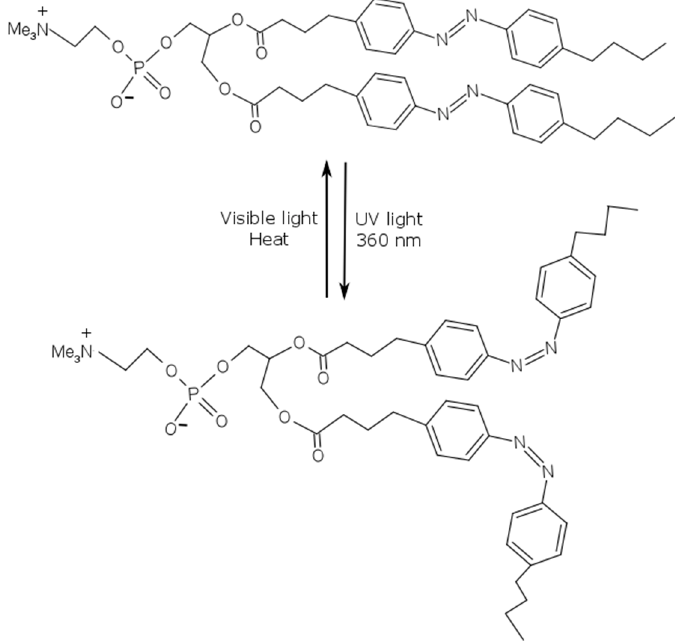
Figure 12. Mechanism of trans–cis isomerization under UV light irradiation of the photochromic lipid, Bis-Azo PC.